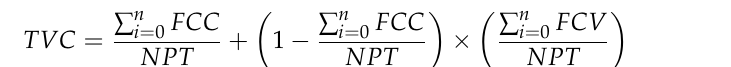
Figure 6. Flowchart for estimating the cover of vegetation vertical strata at sampling sites in the State of Mexico.